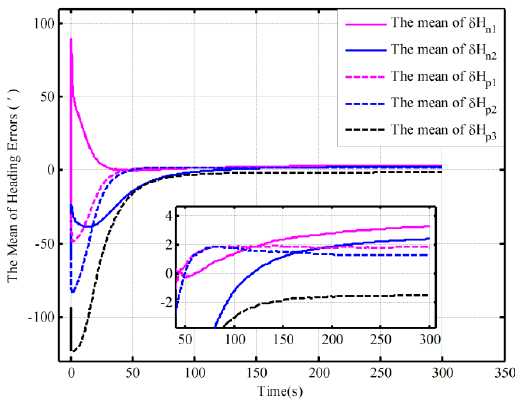
Figure 7. The mean error curves of heading based on the closed-loop KF.